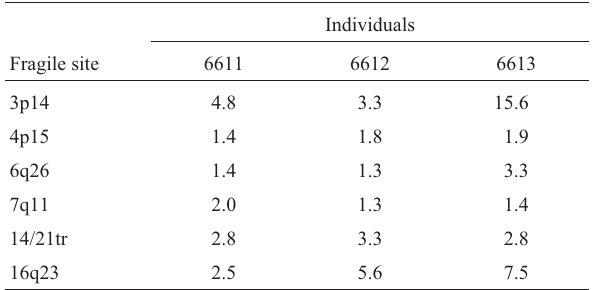
TableIII -Percentageoftotalbreakageateachofthesixsitesidentifiedas fragile in all three translocation-carrying individuals. 14/21tr refers to the fragile site at or near the 14q21q translocation